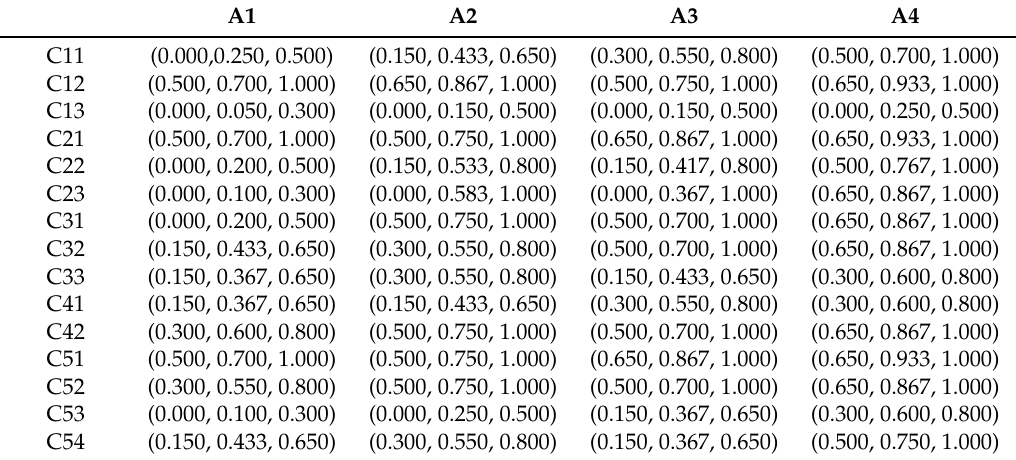
Table 12. Fuzzy PROMETHEE criteria evaluation matrix.